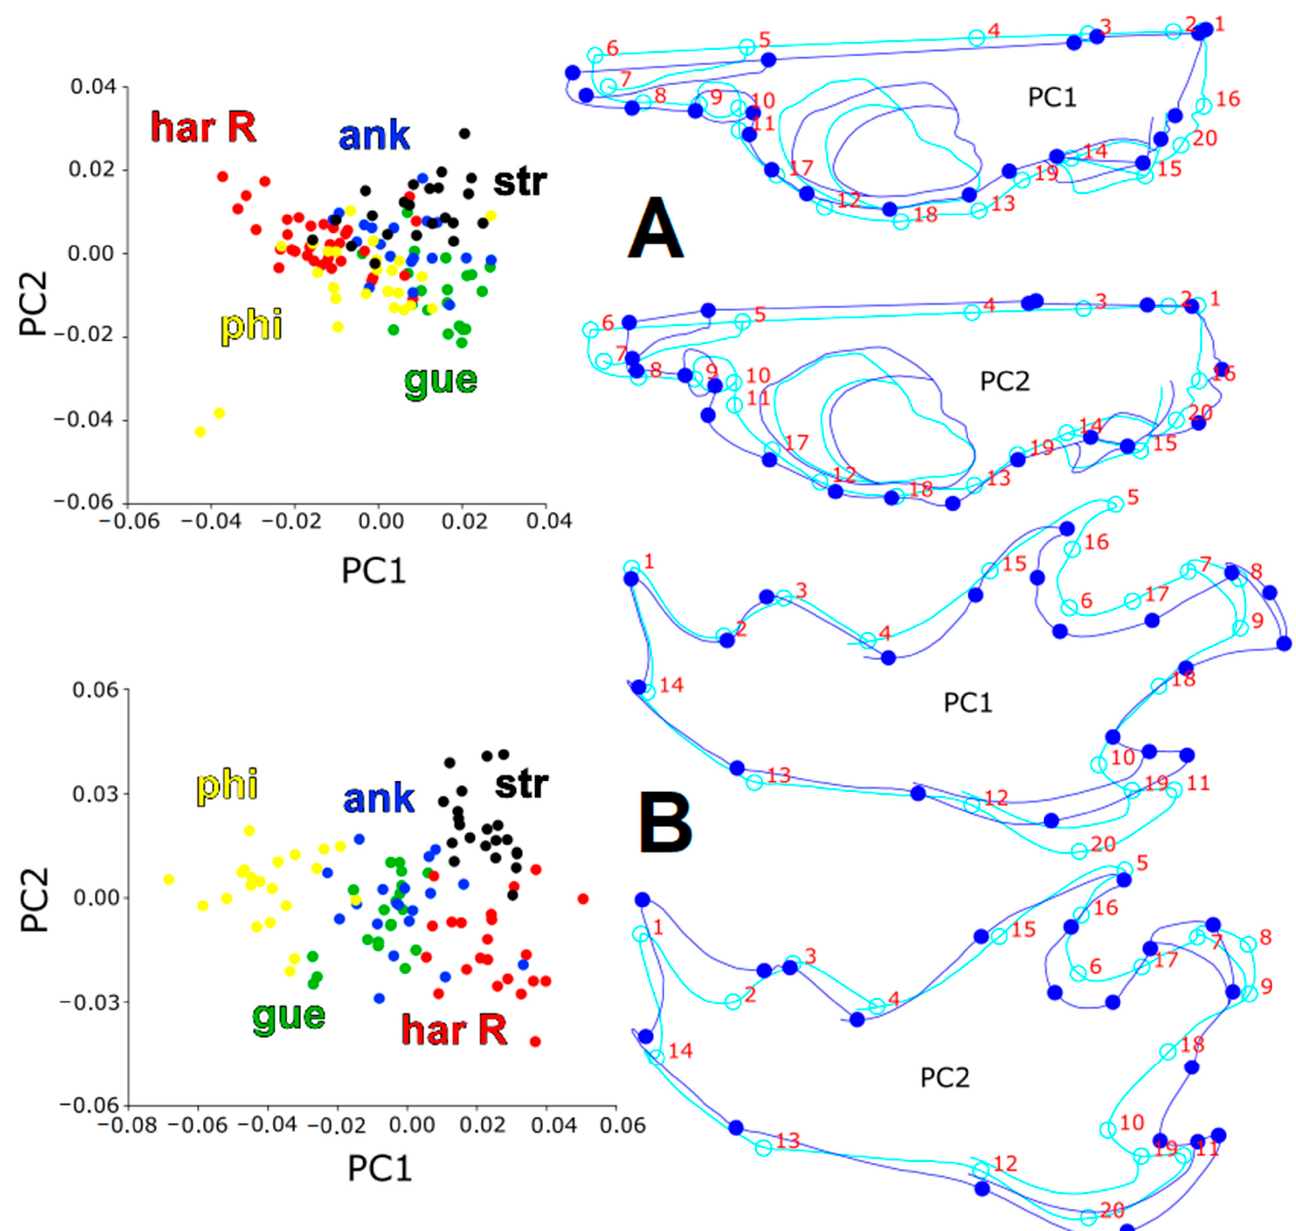
Figure 3. Scatter plots of the PCA (on the left) and positive directional shape changes of PC1 and PC2 (on the right) of the cranial ( A ) and mandibular ( B ) datasets among five vole forms in the “guentheri” group. Blue dots indicate landmarks after shape deformation; red numbers indicate landmark numbers; the scale factor for deformation visualization for the cranium is 0.13, and for the mandible, it is 0.16.